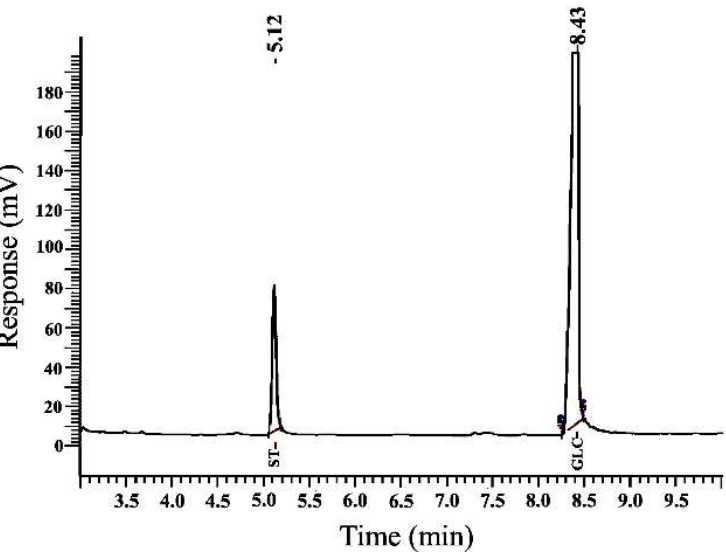
Figure 1. Chromatographic analysis by gas chromatography of an exopolysaccharide obtained from water kefir grains.